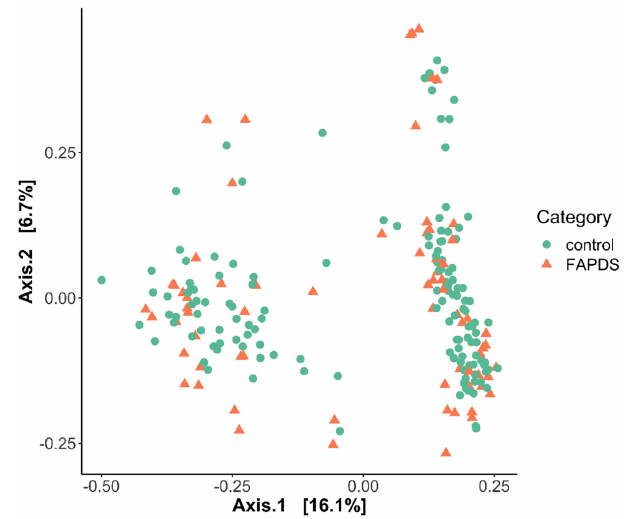
Figure 4. Alpha diversity comparison between the two groups. Shannon, Observed species, and Simpson were higher in the control group than the FAPDs group (Mann–Whitney, p < 0.05). ** denotes significance.